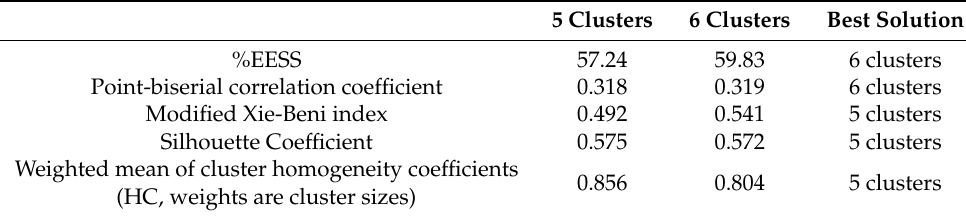
Table 3. Fit indices of the five- and six-cluster solution identified through K-means cluster analysis.